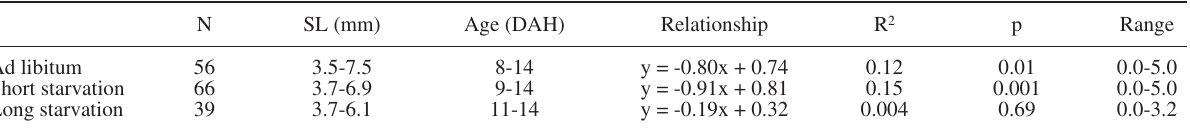
log transformed SL). Not significant p>0.05. 10